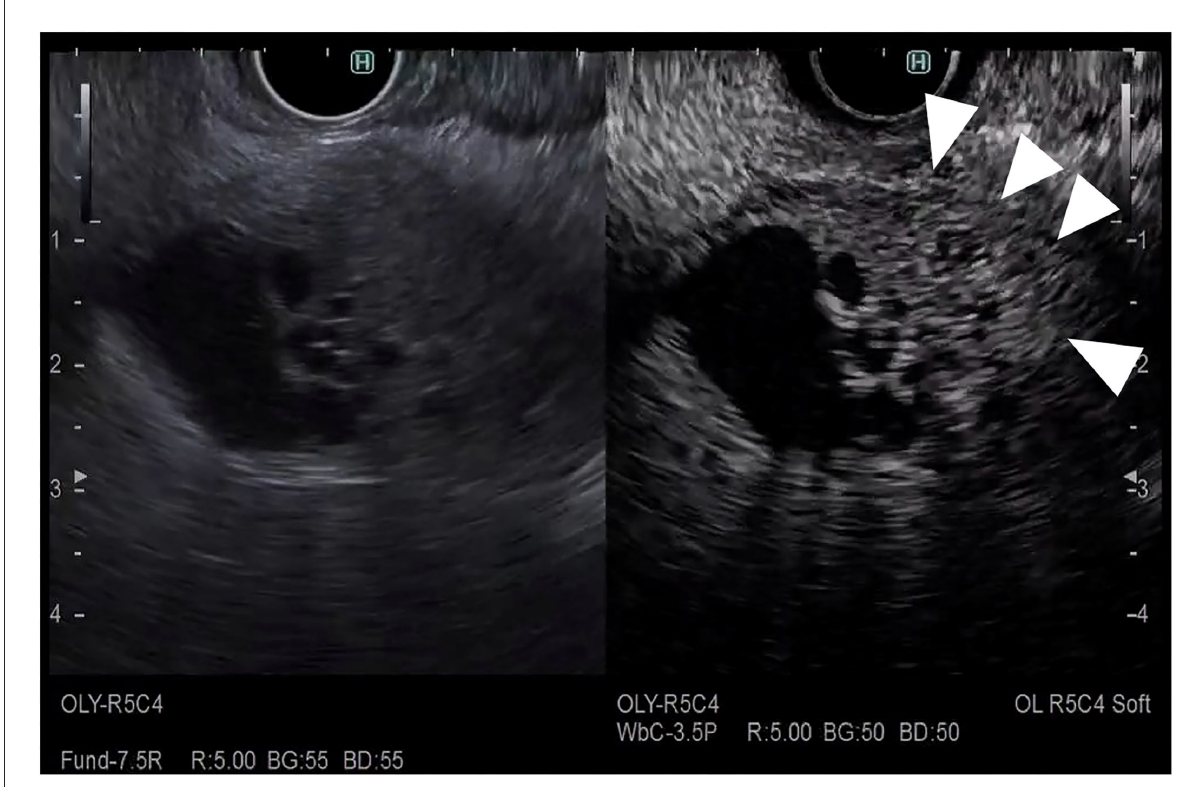
FIGURE11 Contrast-enhanced harmonic EUS for staging of gallbladder carcinoma. T4 gallbladder carcinoma: heterogenous hypoenhancing tumor (arrow) in the gallbladder with disrupted hyperenhacement in the outer layer (arrowhead).